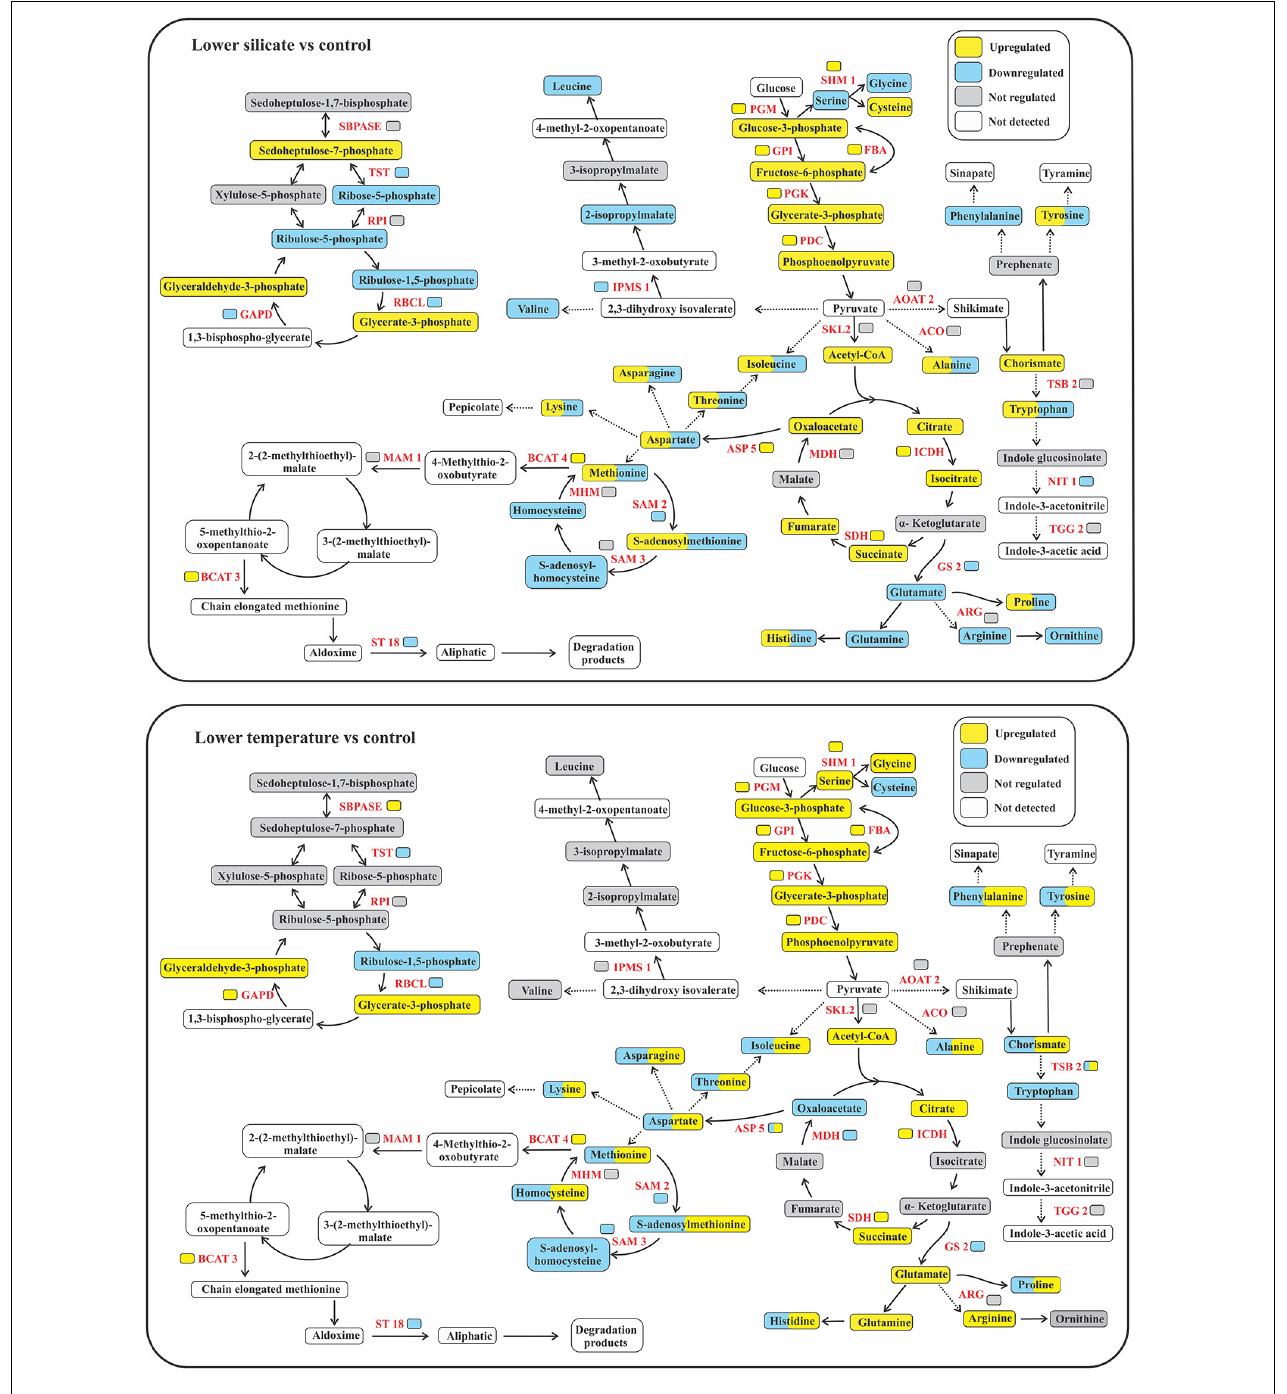
FIGURE 7 | Changes in the protein abundances and carbon flow in the central carbon metabolism of the response of the diatom S. dohrnii to silicate and temperature limitation. SBPASE, Sedoheptulose-1,7-bisphosphatase; RPI, ribulose-5-phosphate isomerase; TST, transketolase; RBCL, ribulose bisphosphate carboxylase large chain; GAPD, glyceraldehyde-3-phosphate dehydrogenase; PGM, phosphoglucomutase; SHM, serine hydroxy-methyltransferase; GPI, glucose-6-phosphate isomerase; PGK, phosphoglycerate kinase; FBA, fructose-bisphosphate aldolase; PDC, pyruvate dehydrogenase; AOAT2, alanine-2-oxoglutarate aminotransferase; SKL, shikimate kinase; ACO, aconitate hydratase; ICDH, isocitrate dehydrogenase; SDH, succinate dehydrogenase; MDH, malate dehydrogenase; ASP5, aspartate aminotransferase 5; SAM2, S-adenosylmethionine synthetase 2; SAM3, S-adenosylmethionine synthetase 3; MHM, 5-methyl-tetra hydropteroyltriglutamate-homocysteine methyltransferase; BCAT4, branched-chain amino acid transaminase 4; MAM, methylthioalkylmalate synthase; BCAT3, branched-chain amino acid transaminase 3; IPMS, 2-isopropylmalate synthase; ST18, sulfotransferase 18; TSB2, tryptophan synthase beta-subunit; NIT, nitrilase; TGG2, thioglucoside glucohydrolase 2; GS2, glutamine synthetase.